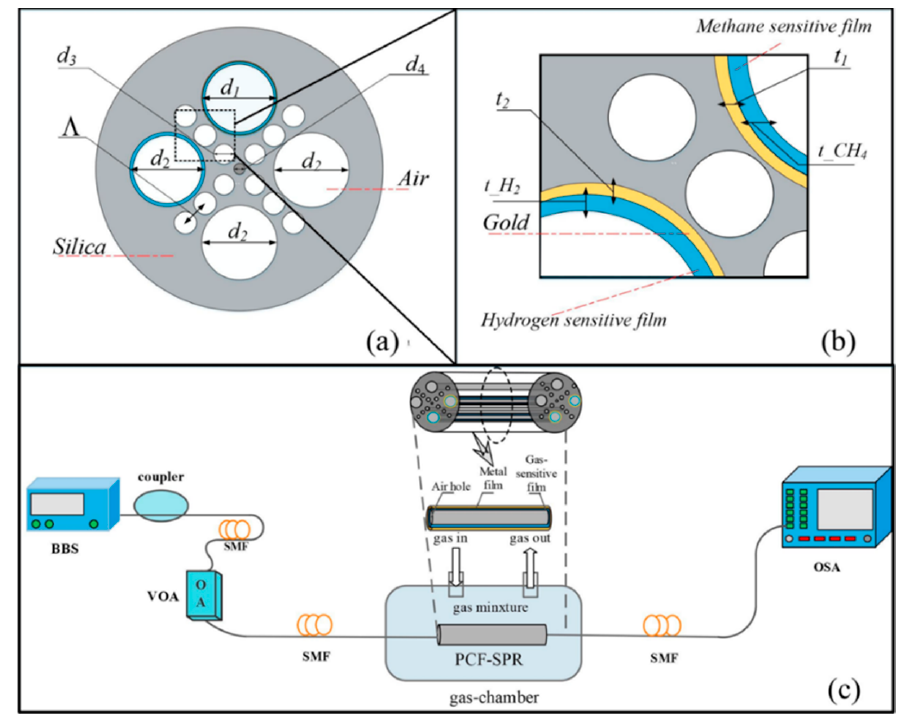
Figure 10. ( a ) The schematic and cross section of SC-PCF sensor; ( b ) structural parameters and; Figure 10. (a) The schematic and cross section of SC-PCF sensor; (b) structural parameters and; (c) ( c ) experimental scheme. Reprinted with permission from experimental scheme. Reprinted with permission from [89].